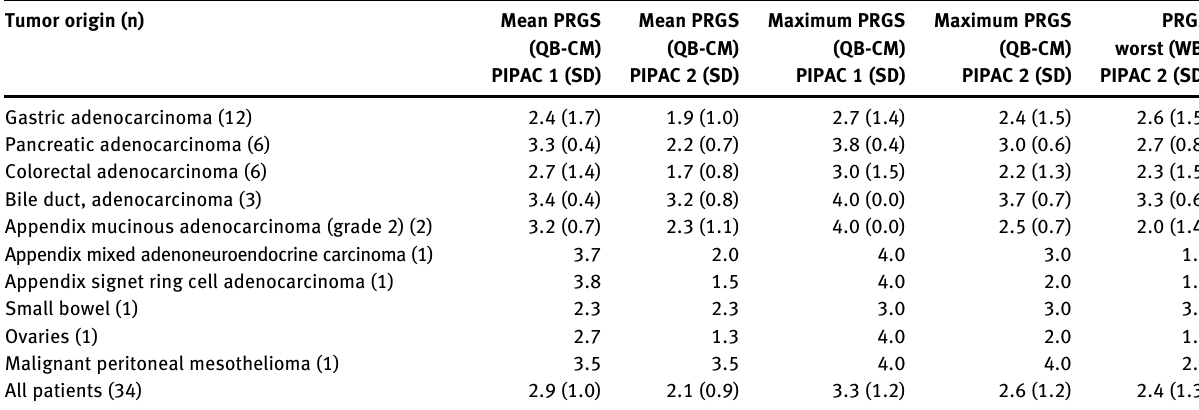
Table  : Peritoneal regression grading score (PRGS) of patients with peritoneal metastasis treated with pressurized intraperitoneal aerosol chemotherapy (PIPAC).